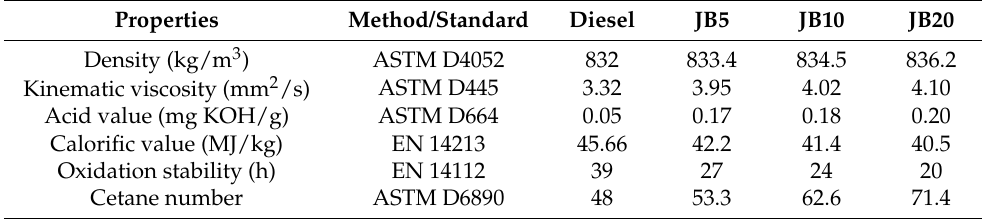
Table 5. Physico-chemical properties of diesel and jojoba ( Simmondsia chinensis ) biodiesel blends.